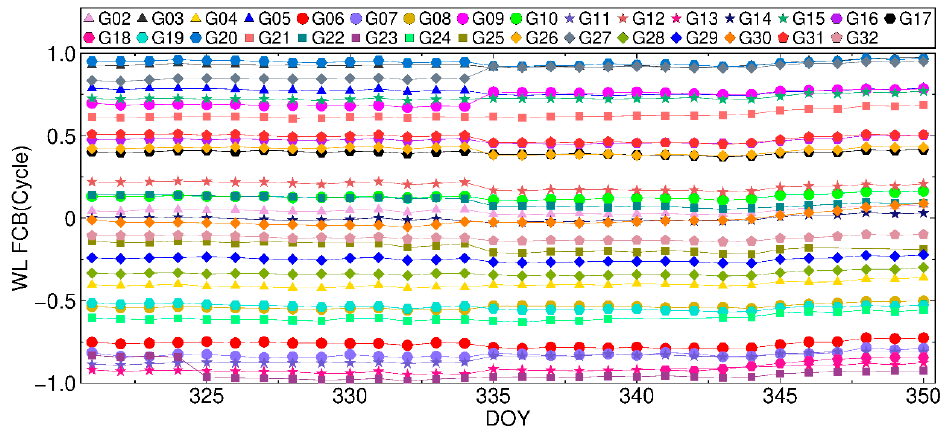
Figure 2. GPS WL FCB from DOY 321 to 350, 2018, referenced to G01.